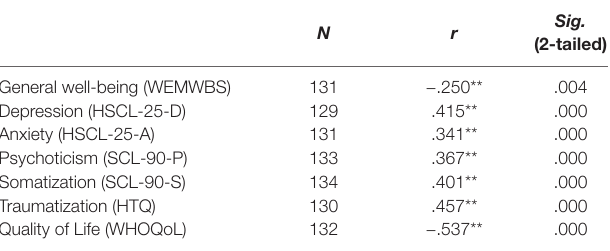
Sig. N r (2-tailed)